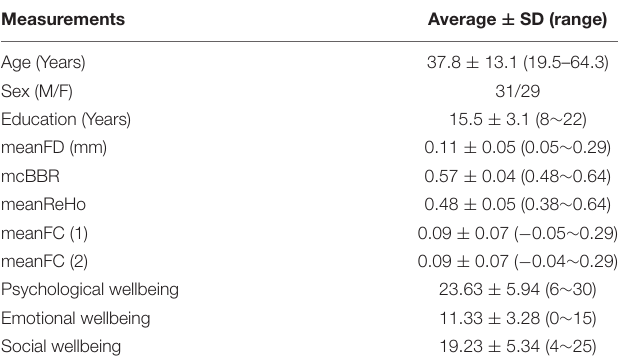
TABLE 1 | Participant information of all the 60 subjects including basic demographics, brain characteristics, and wellbeing scores.